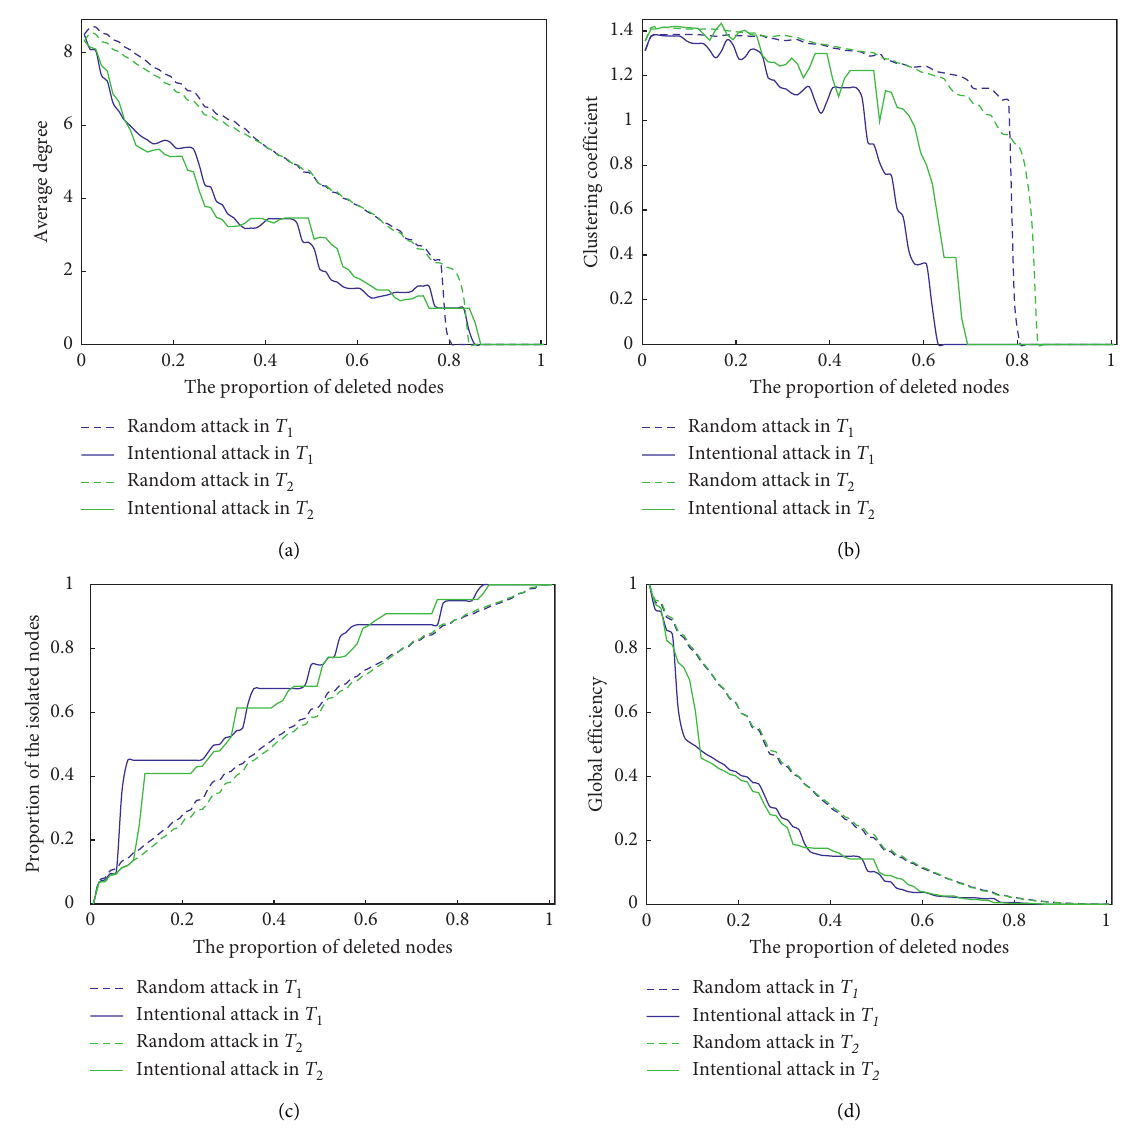
Figure 4: Changes in the network